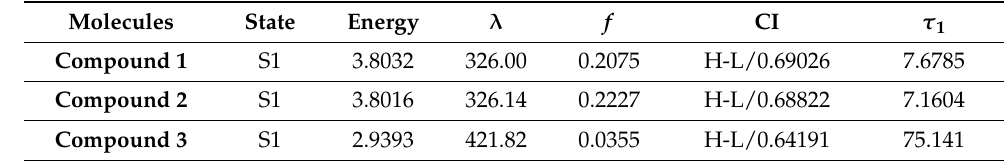
Table 5. The fluorescence energy (eV), fluorescence emission peak (nm), oscillator strengths ( f ), electron transitions and fluorescence lifetime τ 1 (ns) of investigated molecules.